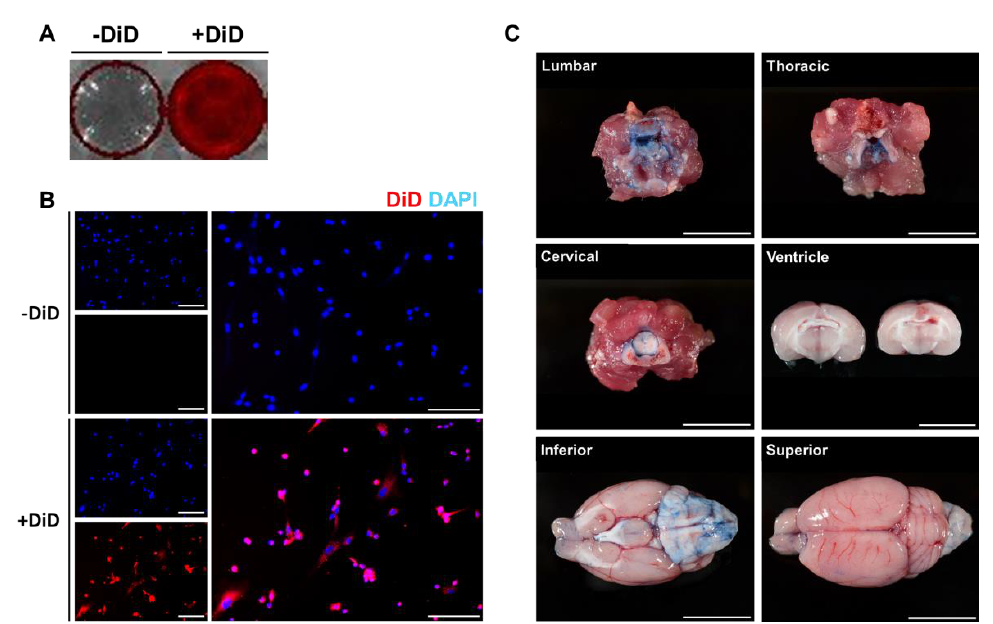
Figure 1. Optimization of DiD labeling and intrathecal delivery. To optimize DiD labeling and intrathecal injection, in vitro and in vivo experiments were carried out, respectively. Fluorescent signals were detected from the DiD-labeled MSCs. ( A ) Red fluorescent signals were visualized from the DiD-labeled MSCs (+DiD) seeded onto 12 well plates. ( B) The fluorescence of the +DiD cells was also confirmed via fluorescence microscopy where no signals were detected from the -DiD control group. Red: DiD, Blue: DAPI (Scale bar: 500μm). ( C ) To confirm our technique for intrathecal delivery, the trypan blue dye was injected into the lumbar space of rat models (Scale bar: 1 cm).